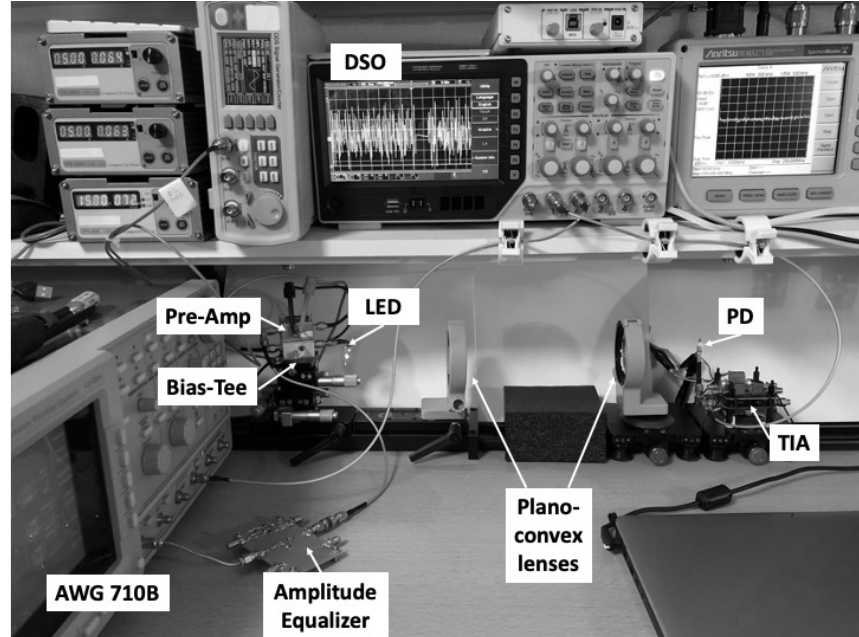
Figure 6. Photograph of the experiment set-up.